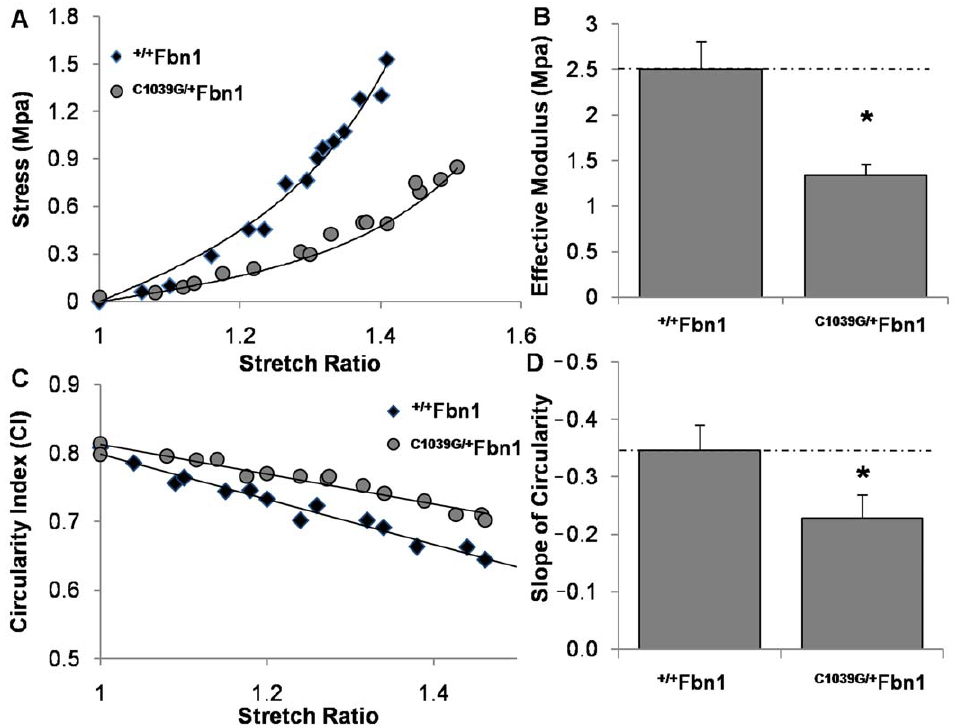
Figure 5. Biomechanical analysis of + / + Fbn1 and C1039G/ + Fbn1 at 4 months. (A) Representative stress-strain responses of mitral valves loaded in the circumferential direction. (B) Stress-strain data were fit to an exponential Fung model, coefficients of which were used to determine effective modulus. (C) Representative stretch induced cell shape changes responses defined by the circularity index (CI)=4*Pi*(Area/Perimeter 2 ). (D) Circularity-index data were modeled as a linear fit, the negative slope of which was used for comparison. Error bars show 6 SD, n $ 6 valves per condition. Asterisks signify statistical differences according to a Student’s t-test (p # 0.05).